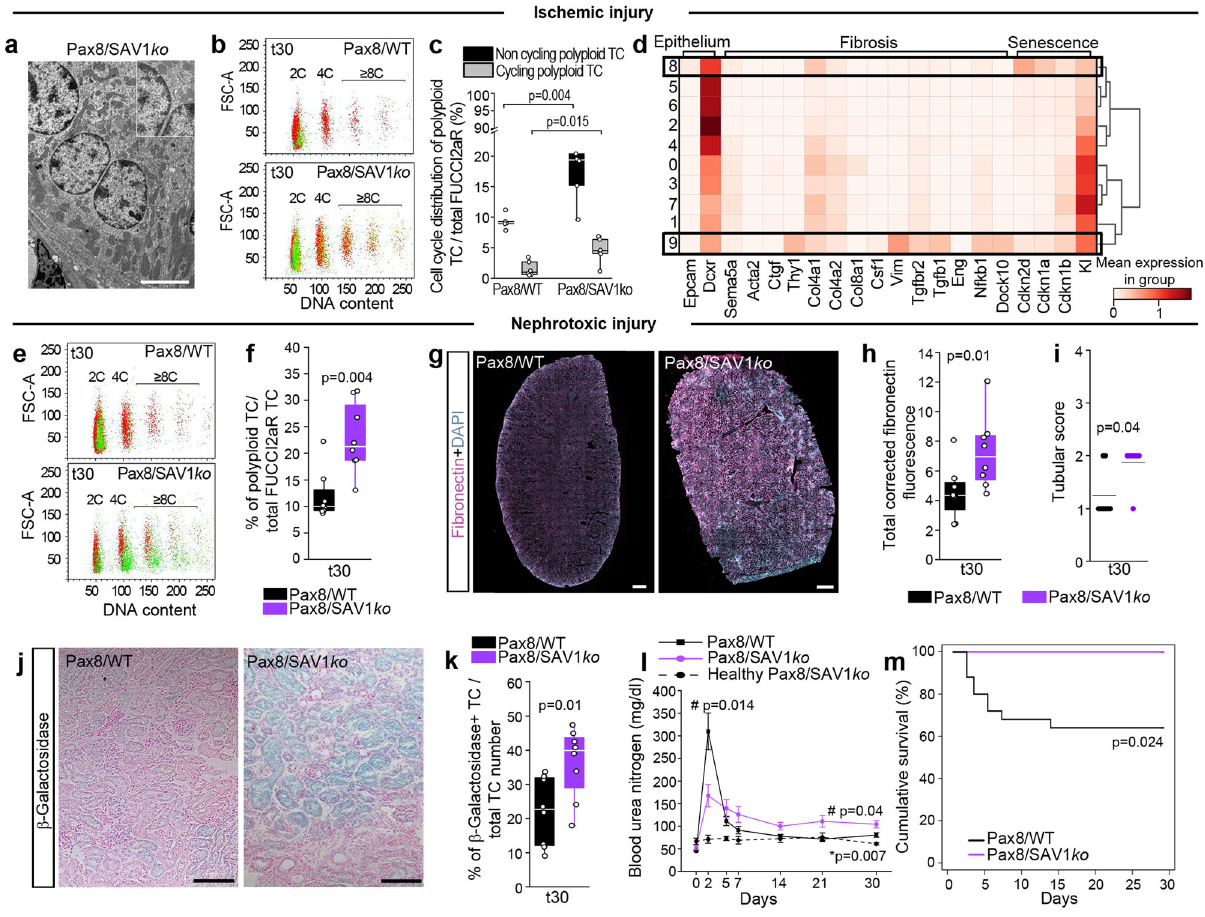
Fig. 7 | YAP1-driven tubular cell (TC) polyploidization attenuates AKI but aggravates AKI-CKD transition. a Transmission electron microscopy of a binu- cleated TCin Pax8/SAV1 ko miceatday 30afterIRI.Bar5 µ m. b FACSplotsofTC in Pax8/WT ( n =6) and in Pax8/SAV1 ko mice ( n =6) at day 30 after IRI, showing diploid (2C), tetraploid(4C) and octaploidorgreater( ≥ 8C) TC. Coloursmatch the FUCCI2aR reporter. c Cell cycle distribution of polyploid TC at day 30 after IRI ( n =6). d Matrix plot showing epithelial, fi brotic and senescence genes in mouse proximal tubular cells at day 2 and 30 after IRI. e FACS plots of TC at day 30 (t30) after nephrotoxic injury in Pax8/WT ( n =8) and in Pax8/SAV1 ko mice ( n =8). f PercentageofpolyploidTCafternephrotoxicinjury( n =8). g Sequentialscanning ofwholekidneysectionsstainedfor fi bronectinatday30afternephrotoxicinjury. DAPIcounterstainsnuclei.Bars500 µ m. h Quanti fi cation of fi bronectindeposition by digital morphometryafter nephrotoxic injury( n =8). i Tubularscore evaluated